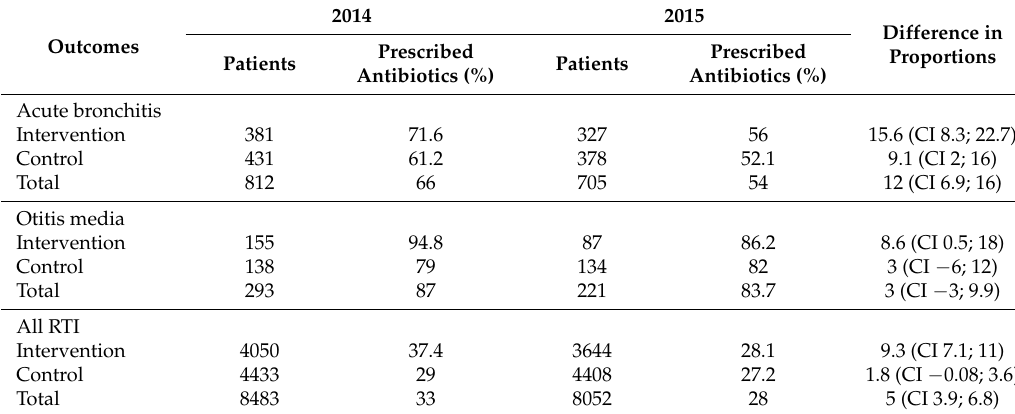
Table 2. Prescription of antibiotics in 2014 and 2015.